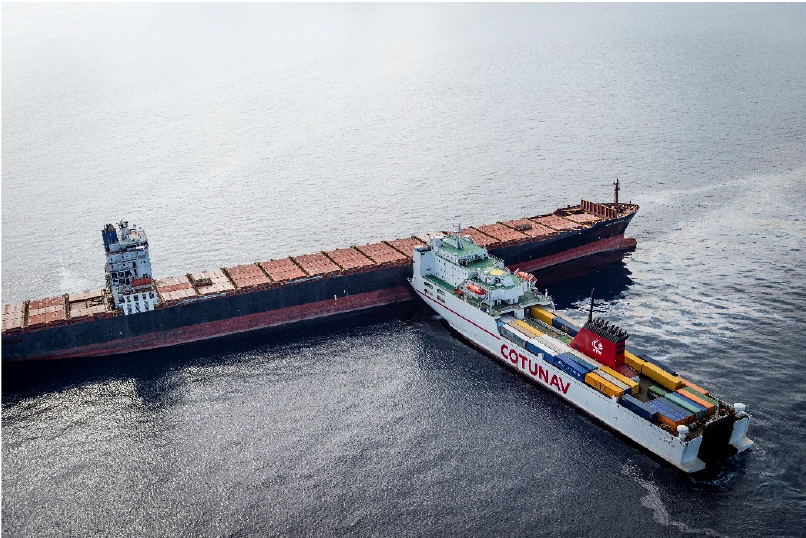
Figure 4. An example of a ship ‐ to ‐ ship collision in the Mediterranean Sea on 8 October 2018. The instant opening of the related collision damage is more a myth than a sound physical assumption. Photo: © picture ‐ alliance/AP Photo/Marine Nationale/Benoit Emile.